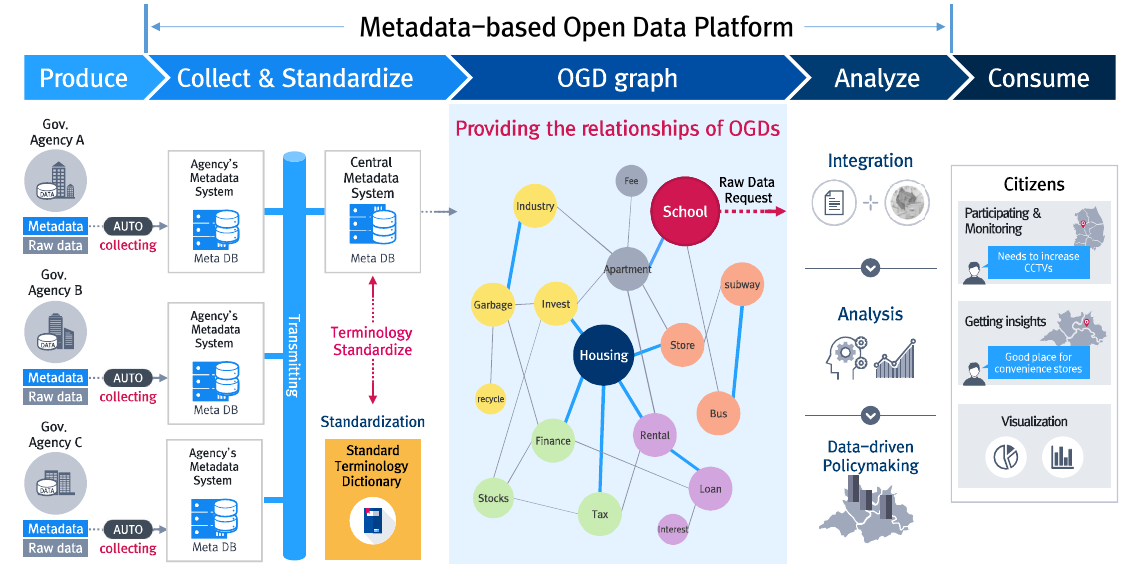
Figure 1. Conceptual Model of Metadata-based Open-Data